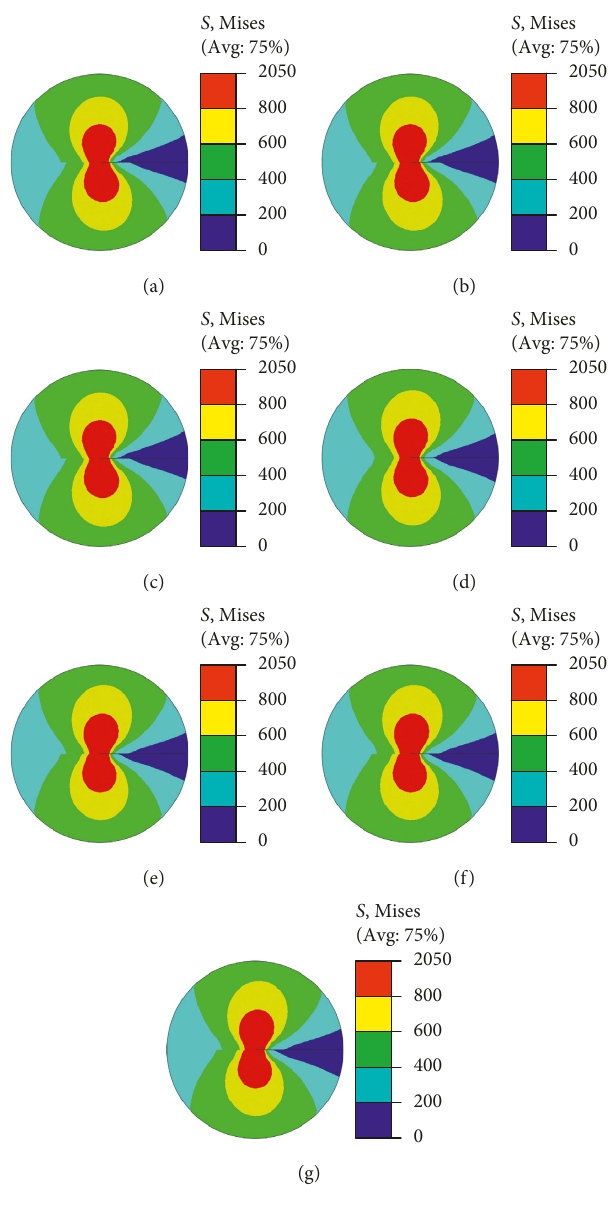
Figure 11: The Mises stress contour of “sandwich” material structure model around crack tip. (a) M � 0.7. (b) M � 0.8. (c) M � 0.9. (d) M � 1.0. (e) M � 1.1. (f) M � 1.2. (g) M �